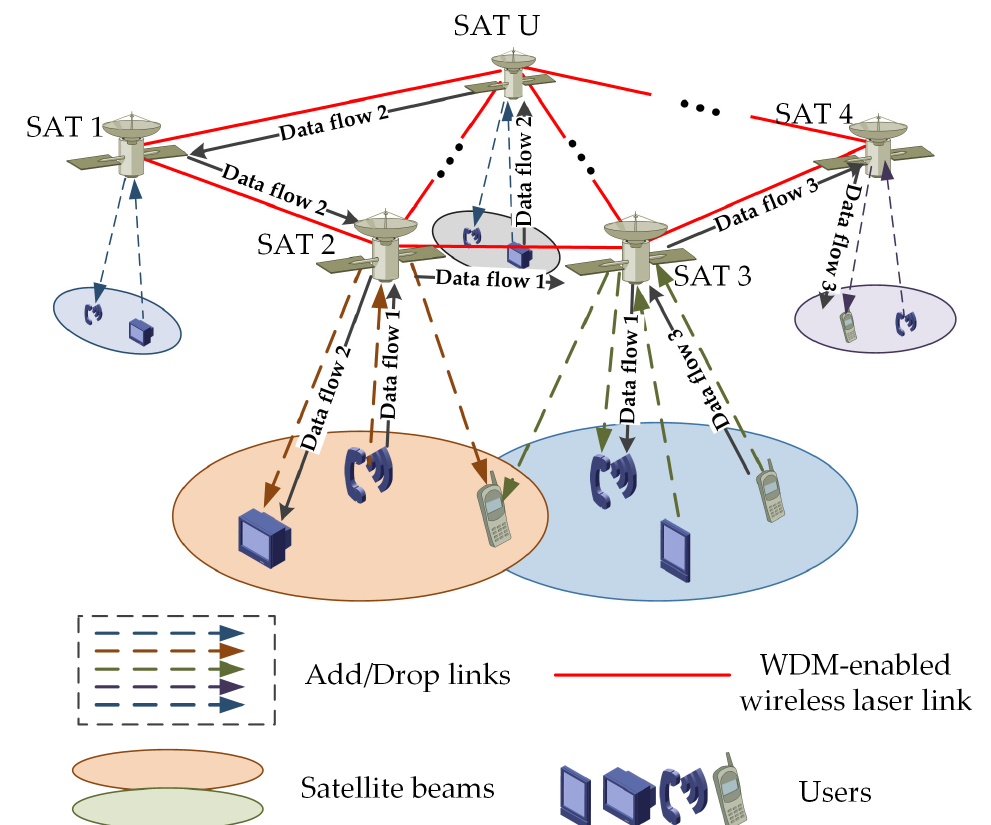
Figure 1. A group of U satellites is interconnected by sparse WDM-enabled wireless laser links, providing services for users within its coverage, where three data flows traverse from the sources to destinations.